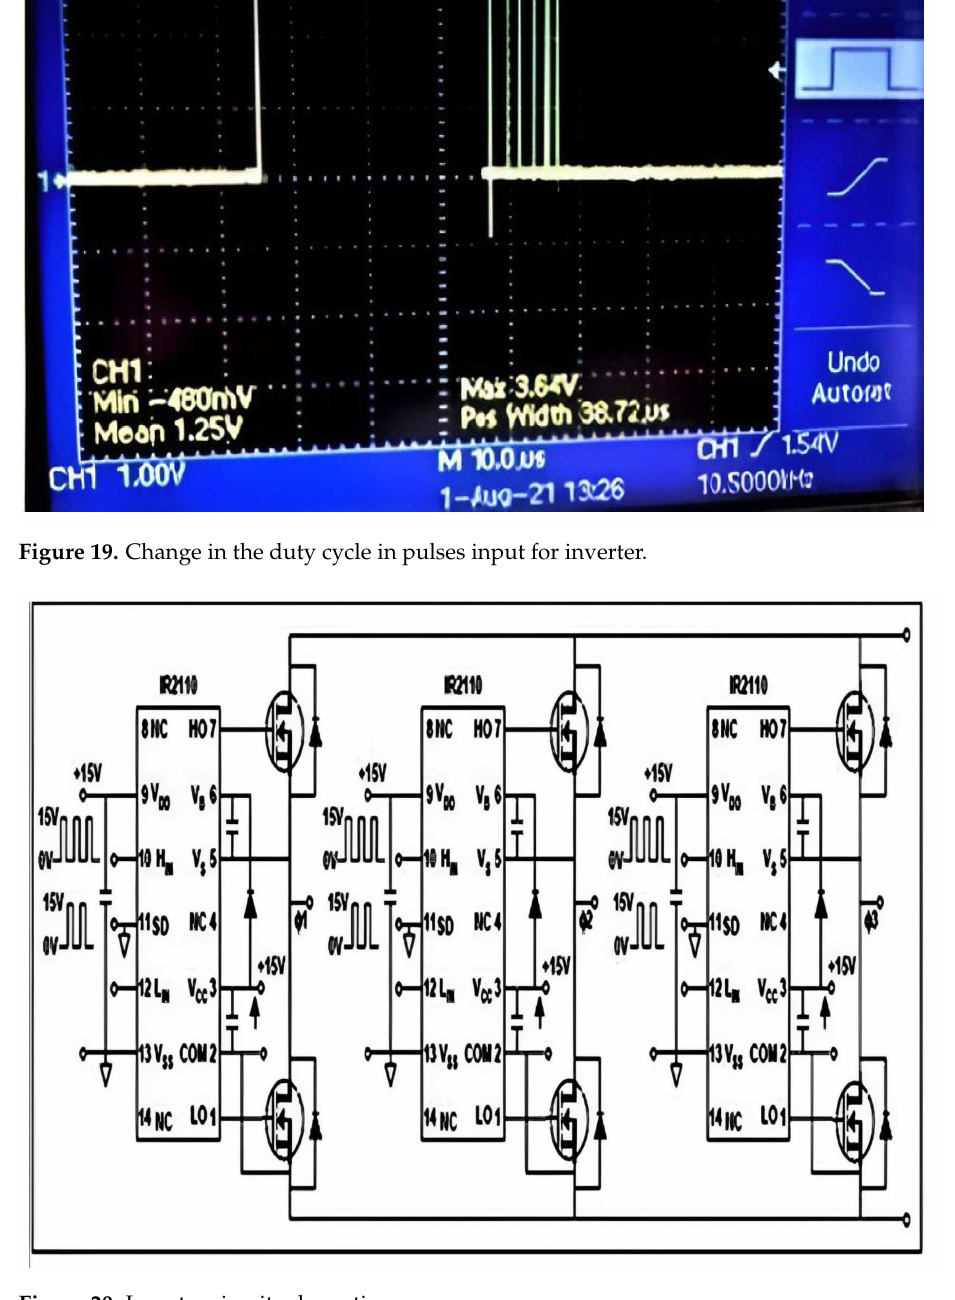
Figure 20. Inverter circuit schematic. Table 4. Inverter